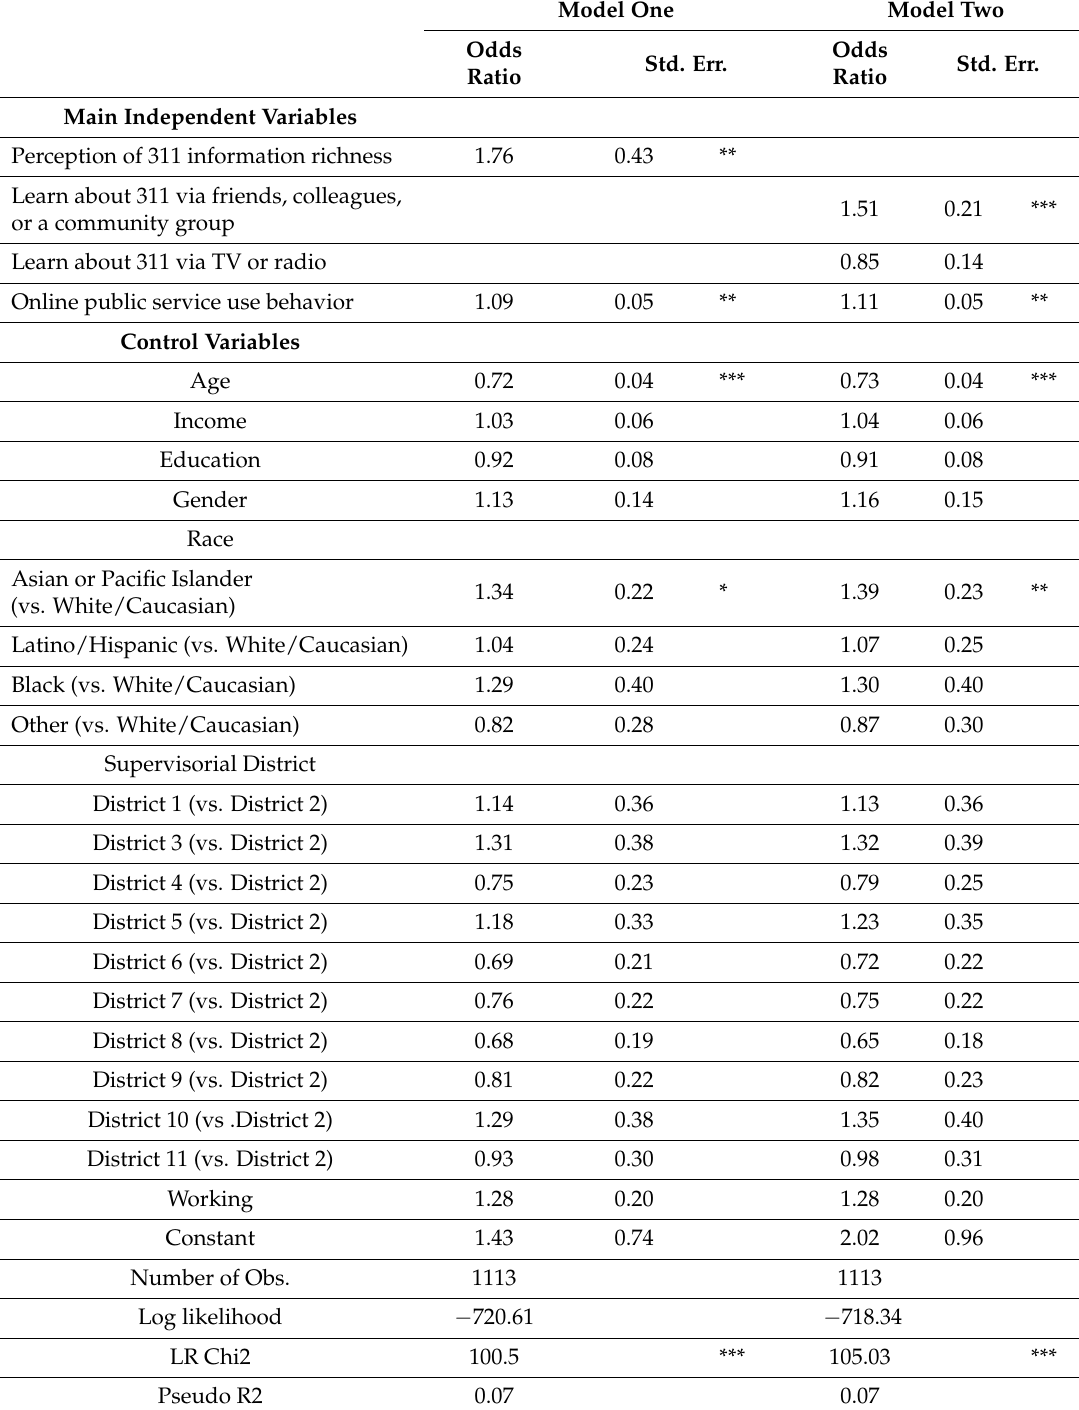
Table 3. Logistic regression results exploring 311 contact channel